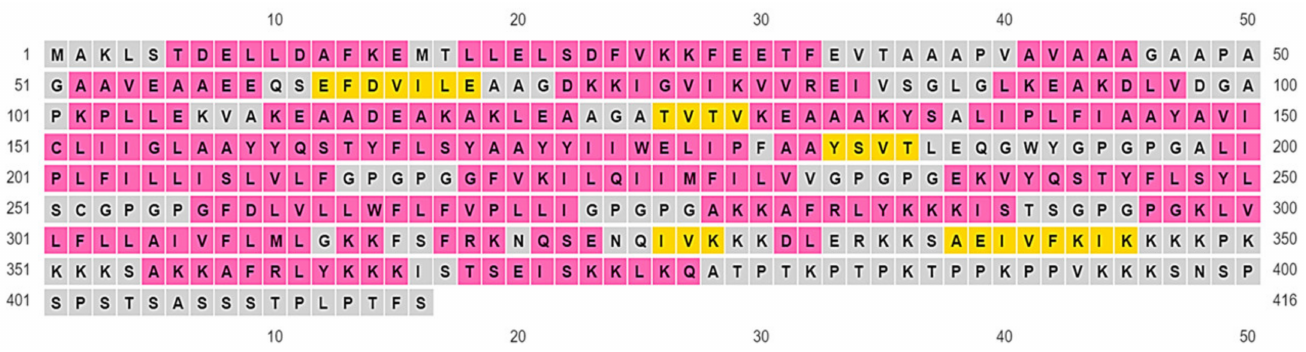
Figure 4. Color-coded annotation grid representing the secondary elements of the antigenic chimera as produced by PSIPRED 4.0. Yellow: Strands, Pink: Helix, Gray: